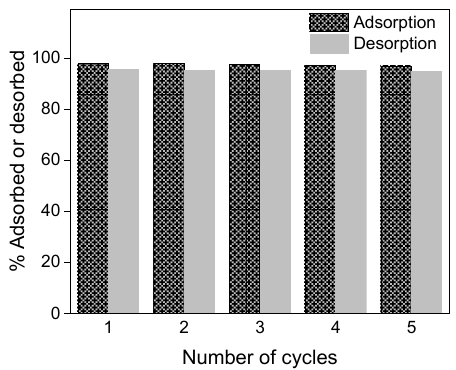
Figure 7. Adsorption/desorption cycles for removal of As(V) using permethylated β -CD impregnated resin .